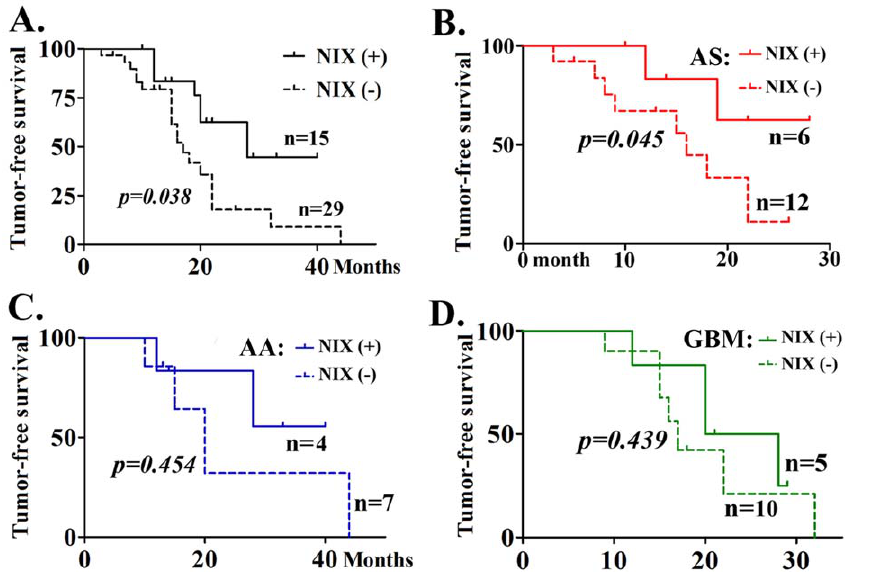
Figure 5. According to long-term follow-up of the Nix ( + ) and ( 2 ) groups of patients, tumor-free survival by Kaplan-Meier analysis criteria was significantly different in the total cases ( p=0.038 ) and in astrocytoma patients (Grade II) ( p=0.045 ), but not in AA (Grade III) and GBM (Grade IV) patients.